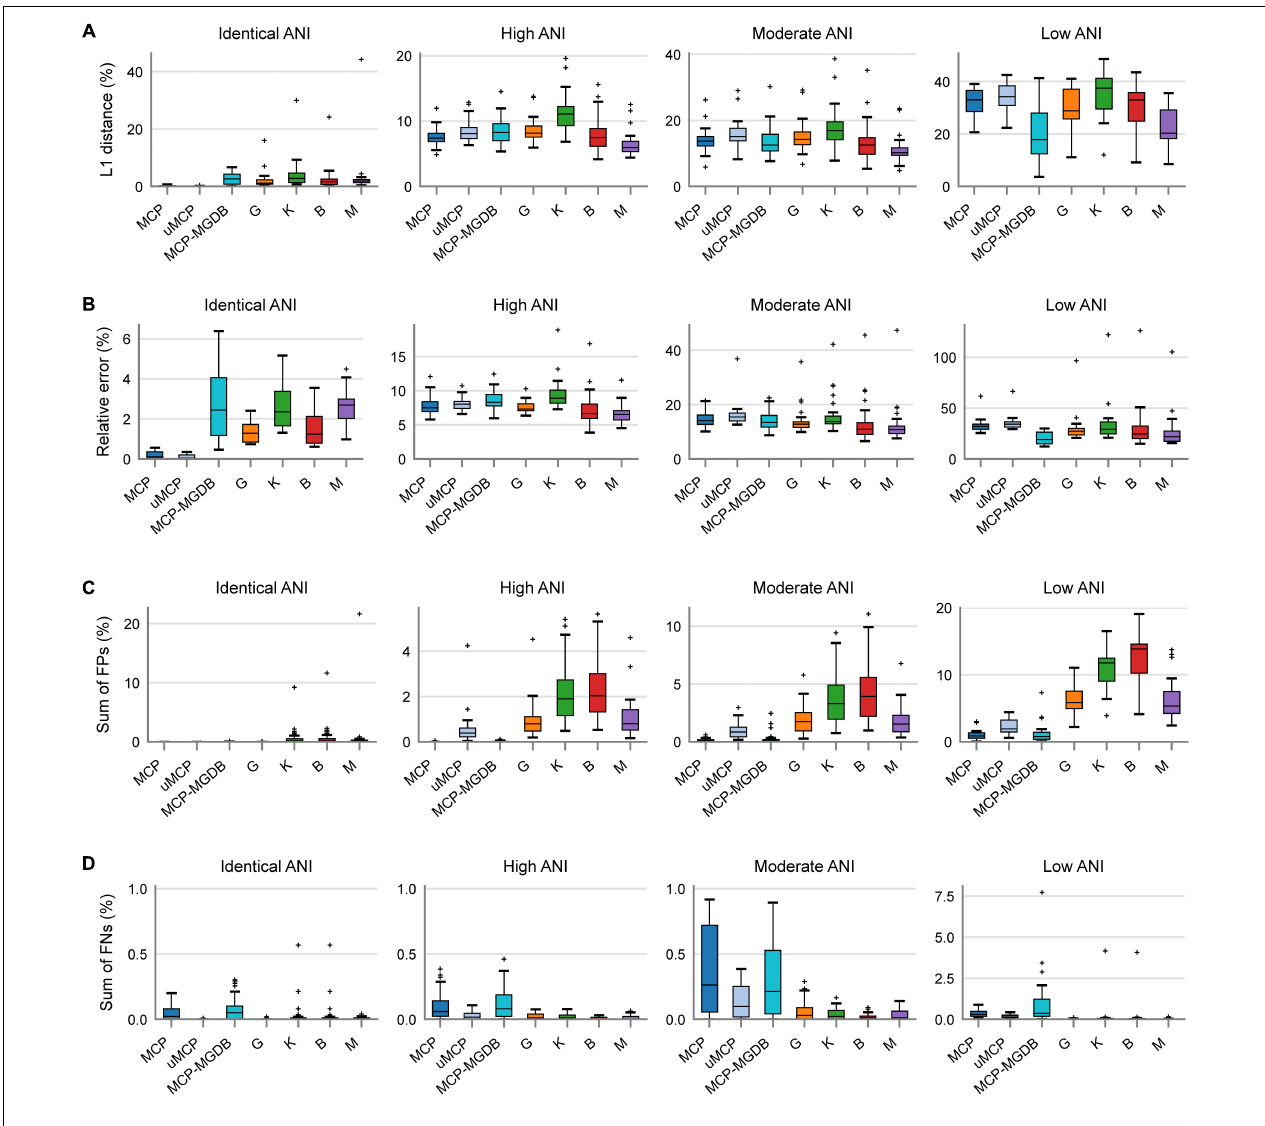
FIGURE 3 | Performance of metagenomic classifiers to predict species abundances. (A) L1 distance (0% = identical to ground truth; 200% = no species in common with ground truth) between the ground truth and predicted species profiles. (B) Mean relative error of species present in both the ground truth and predicted species profiles. (C) Sum of false positive species abundances. (D) Sum of false negative species abundances. Lower values indicate better performance. Results are provided across mock communities of increasing ANI divergence from the reference database. Results for Centrifuge, DIAMOND-LCA, Kaiju, and mOTUs are not shown as they have substantially worse species abundance estimates than the other classifiers ( Supplementary Figure 2